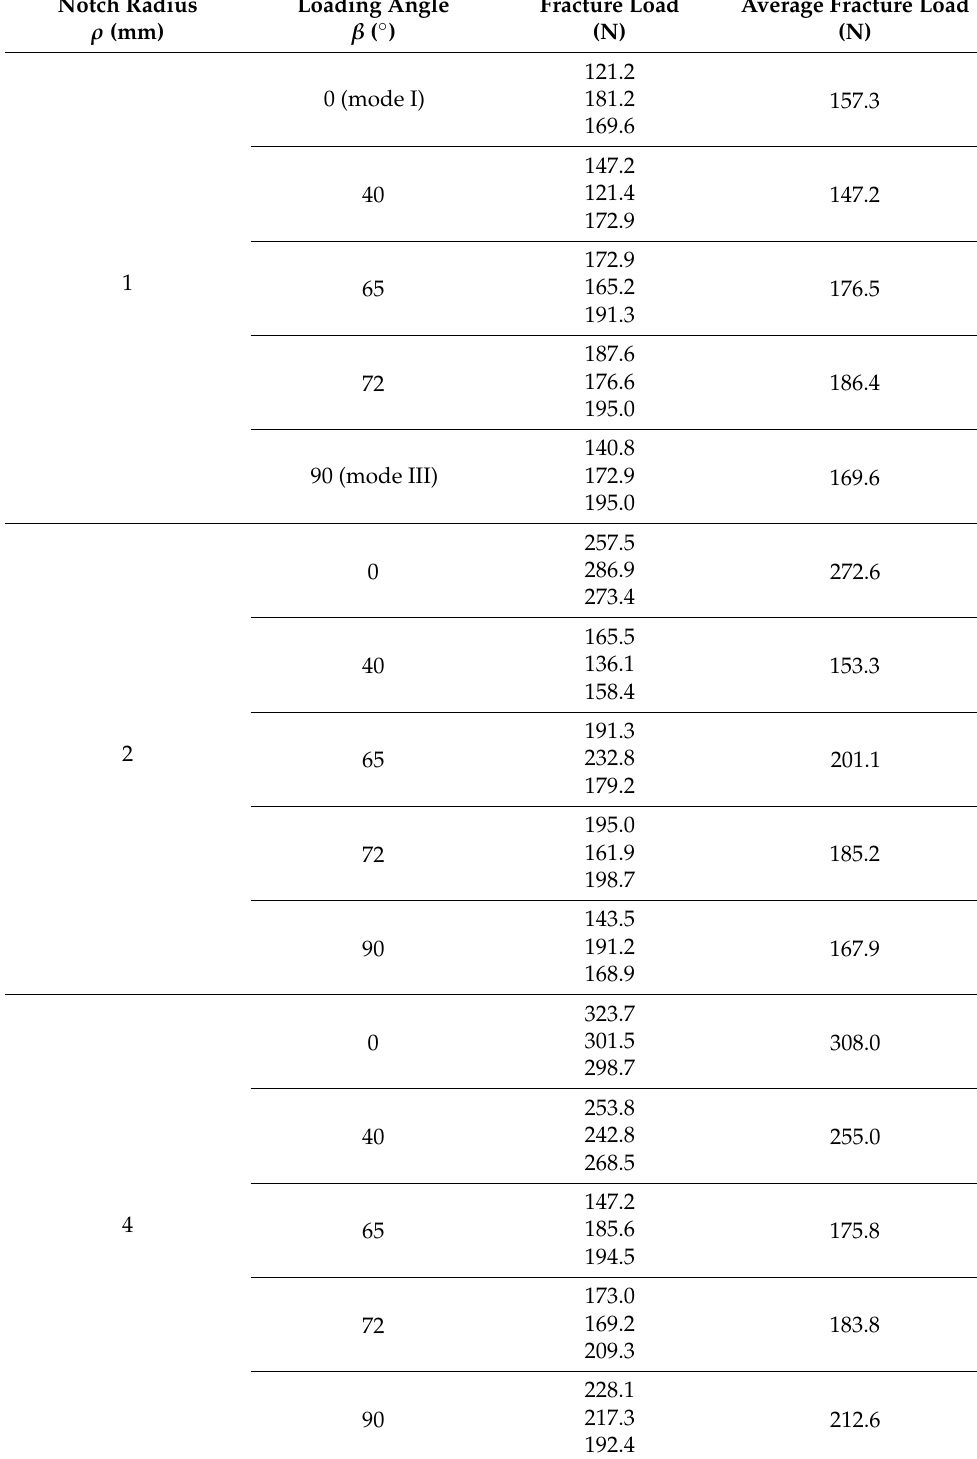
Table 2. Fracture loads of the U-notched spruce wood fracture